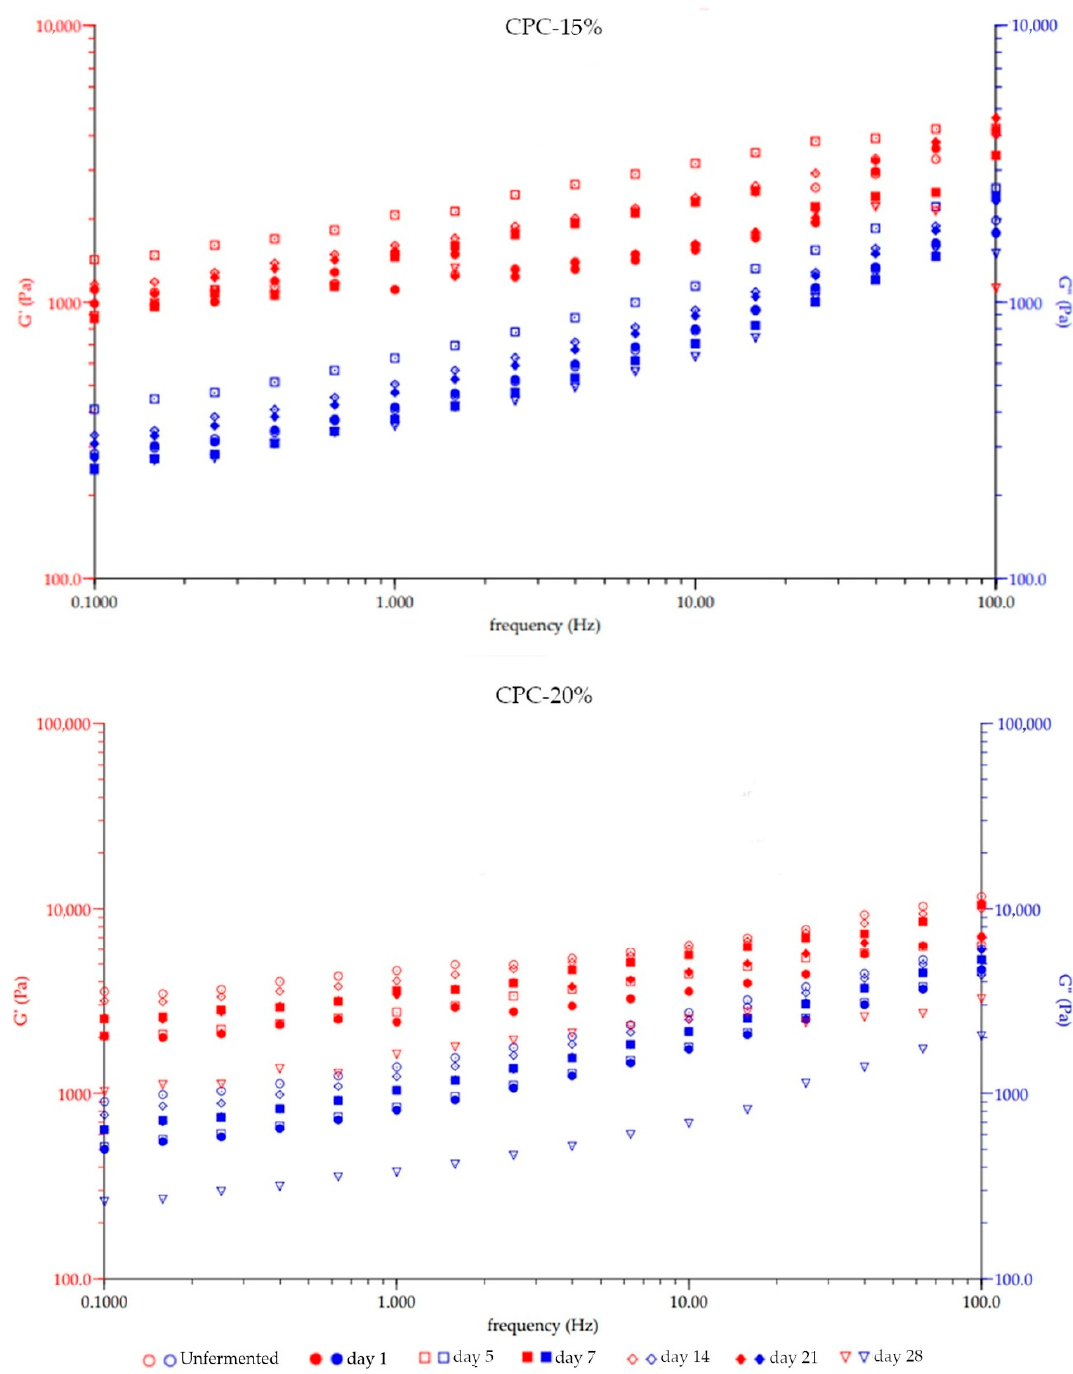
Figure 2. The changes in G ′ (storage modulus) and G ″ (loss